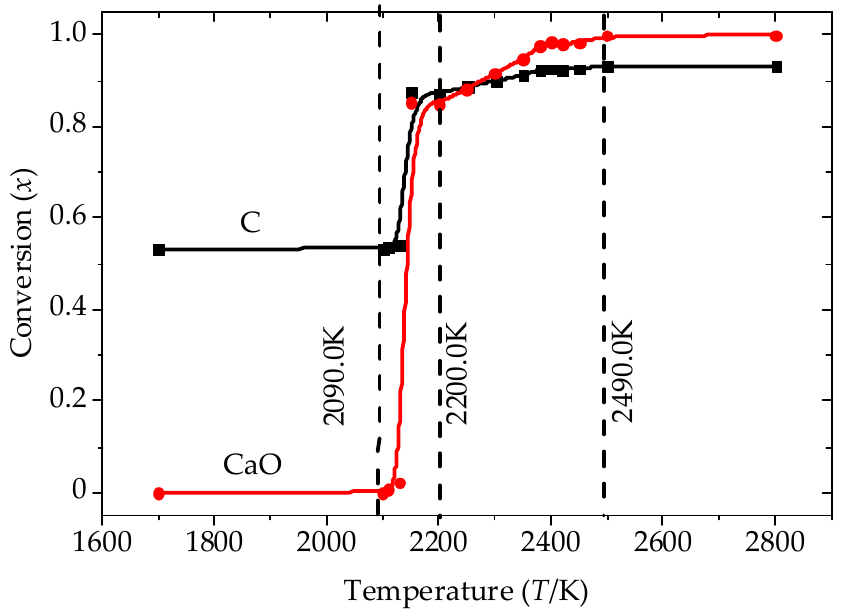
Figure 12. The conversion of C and CaO at each reaction temperature.